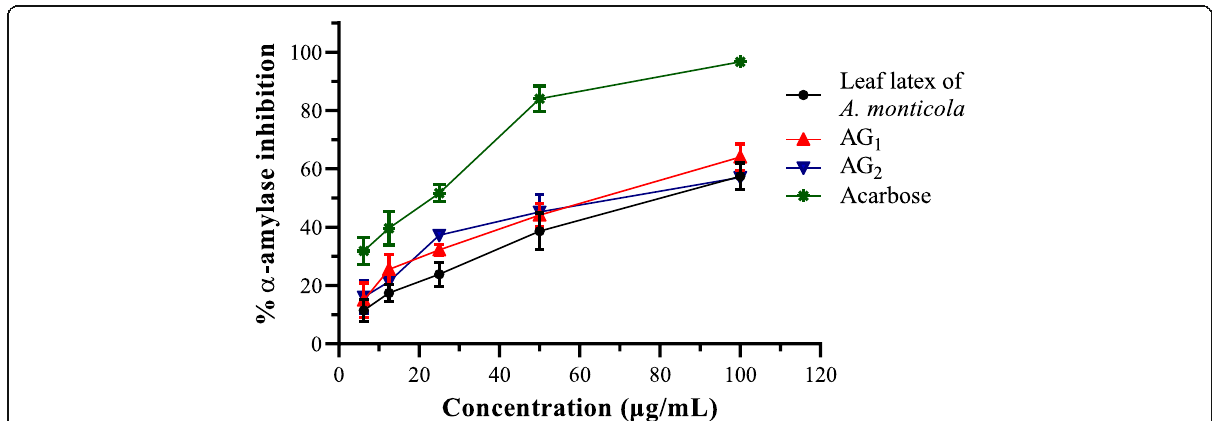
Fig. 2 Plot of percent α -amylase inhibitory effect versus different concentrations of leaves latex, AG 1 , and AG 2 of A. monticola